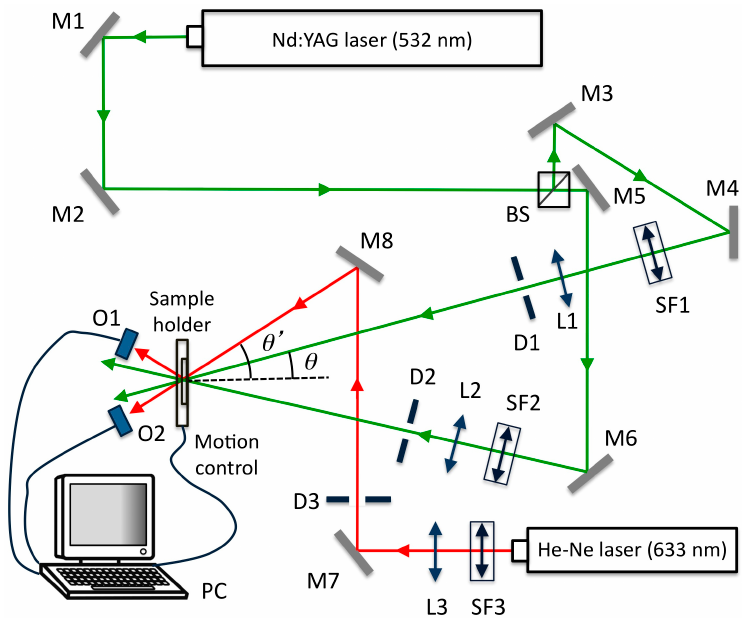
Figure 6. Optical set-up. BS: Beamsplitter, Mi: mirror, SFi: spatial filter, Li: lens, Di: diaphragm, Oi: optical power meter, PC: data recorder.